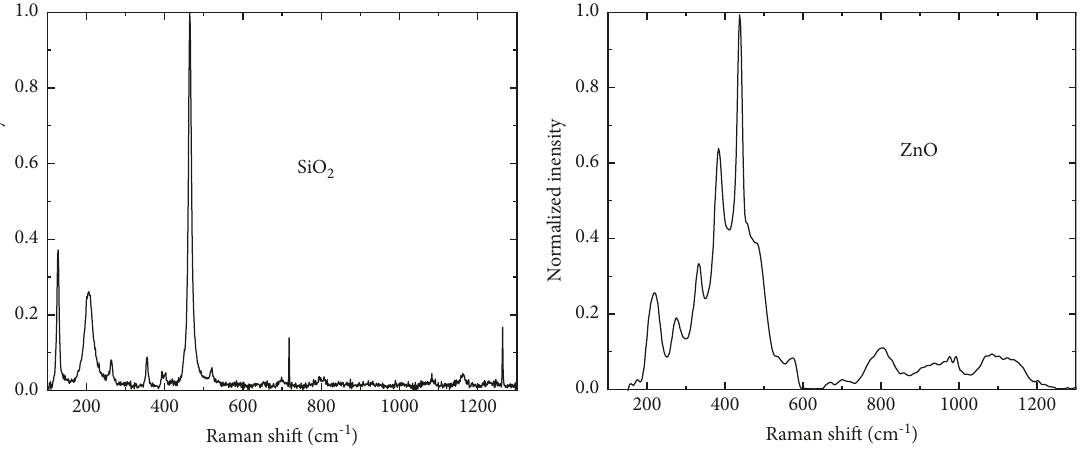
Figure 4: Raman spectra SiO